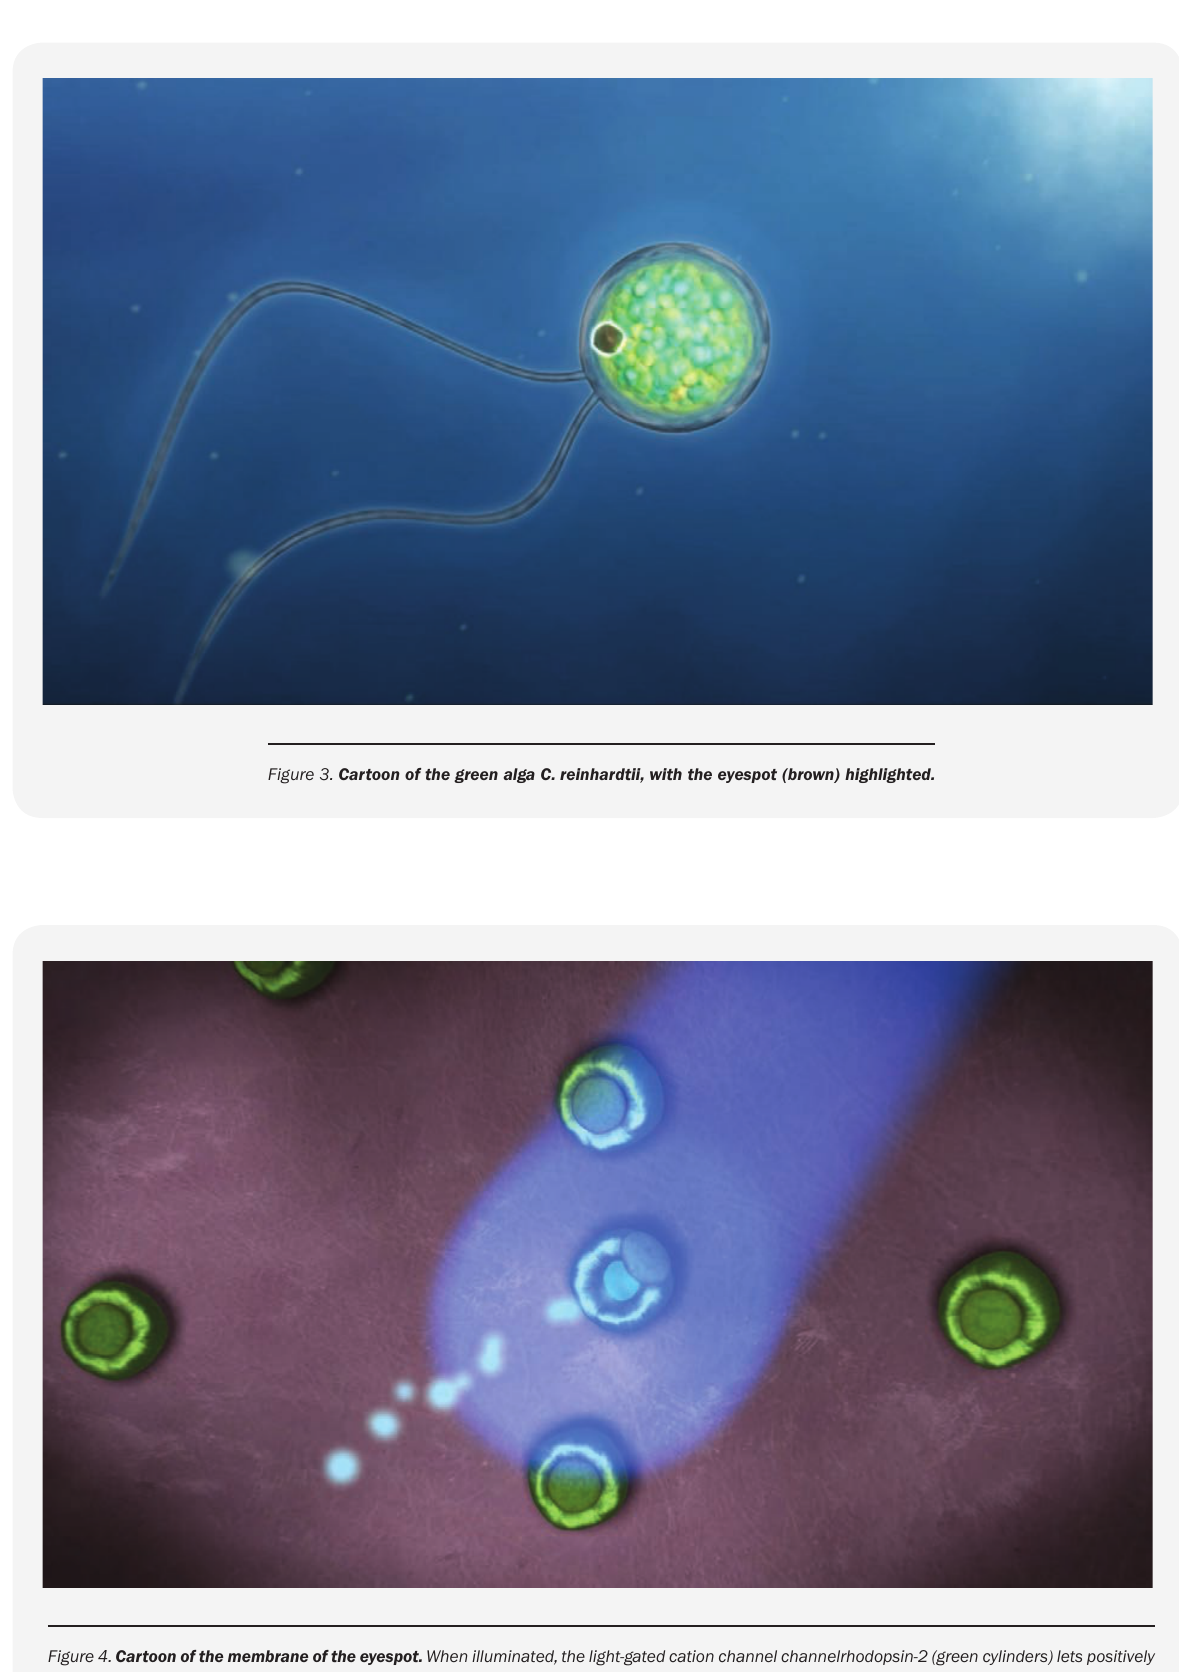
Figure 4. Cartoon of the membrane of the eyespot. When illuminated, the light-gated cation channel channelrhodopsin-2 (green cylinders) lets positively charged ions through the membrane of the